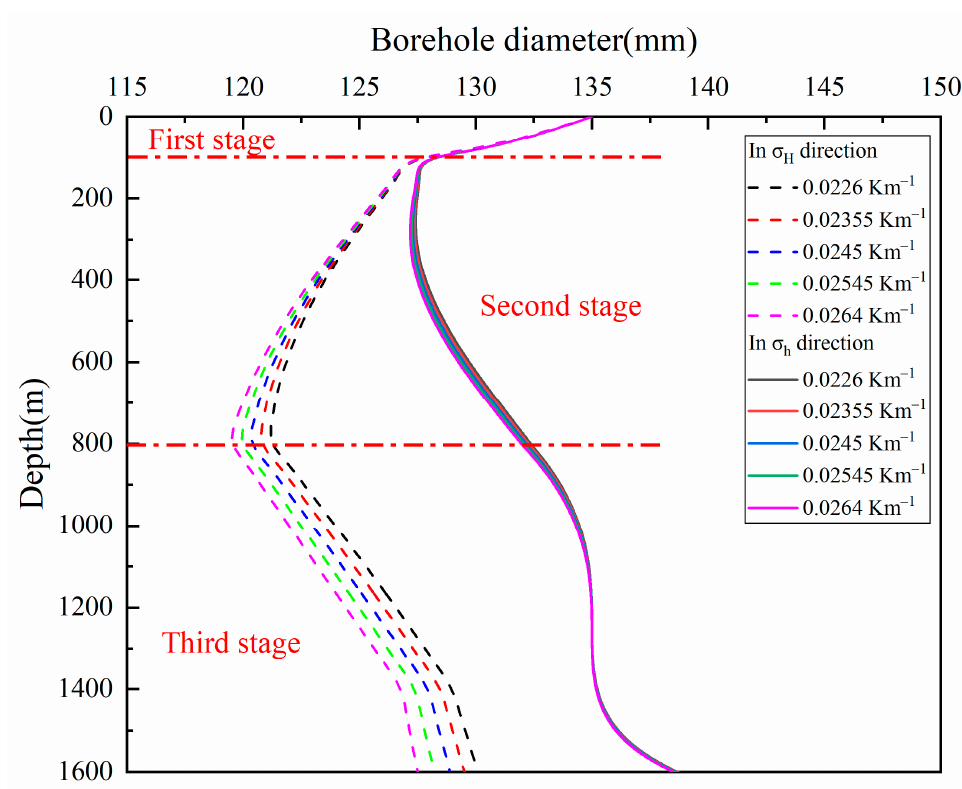
Figure 8. Sensitivity analysis of changes in borehole diameter with temperature gradient in one year.